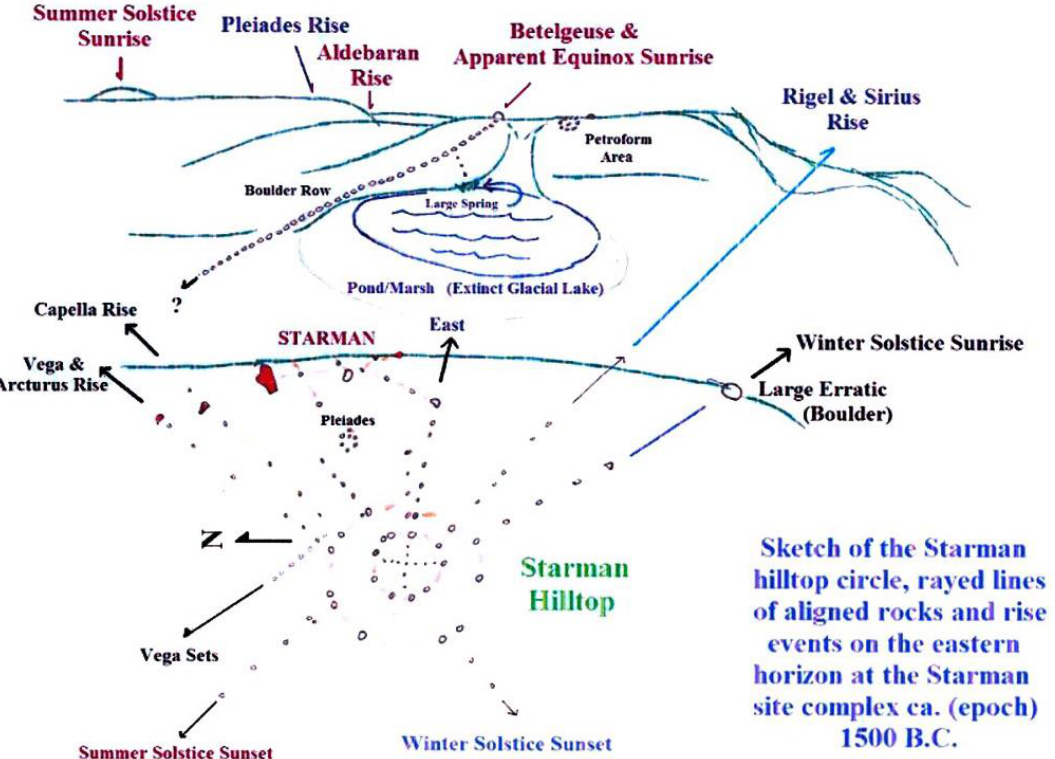
Figure 14. Sketch map of the Starman site showing the cross-in-circle hilltop circle and alignments of spaced rocks radiating toward the eastern horizon where star and solstice sunrises and sunsets were observed. Note also the large erratic boulder on the winter solstice sunrise alignment or azimuth (Figure 13). According to long term land owners whose properties have been in the same families for generations, cairns were located on distant hilltops in-line with the proposed stellar alignments before being destroyed by post-World War 2 agricultural land clearing.